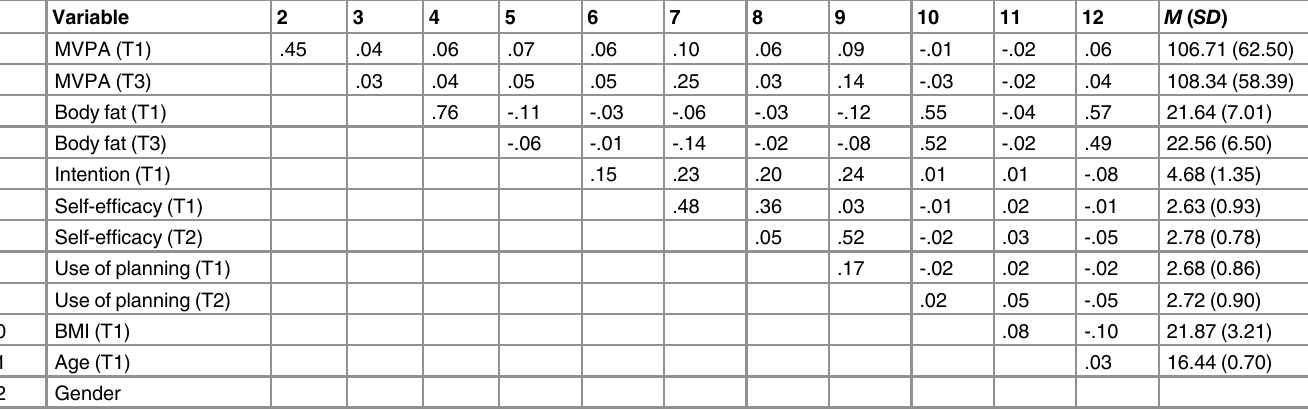
Table 1. Correlations between study variables and descriptive statistics for the total sample ( N = 1217). Variable